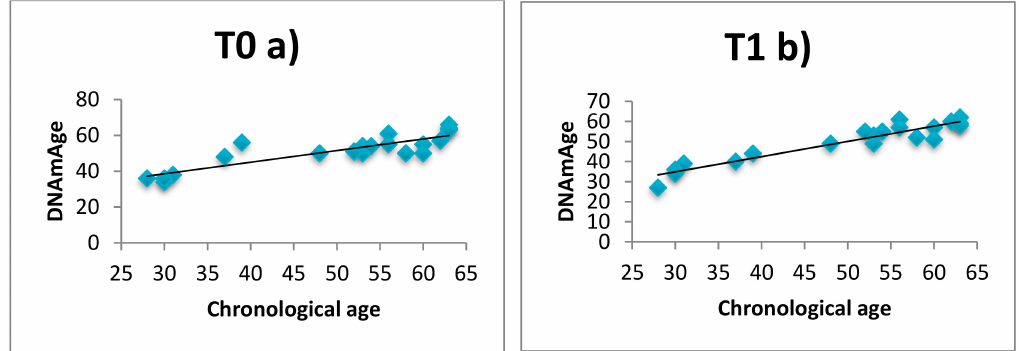
Figure 2. Correlation curves between DNAmAge and chronological age at enrolment T0 ( a ) versus after 60 days of relaxing practices T1 ( b ).